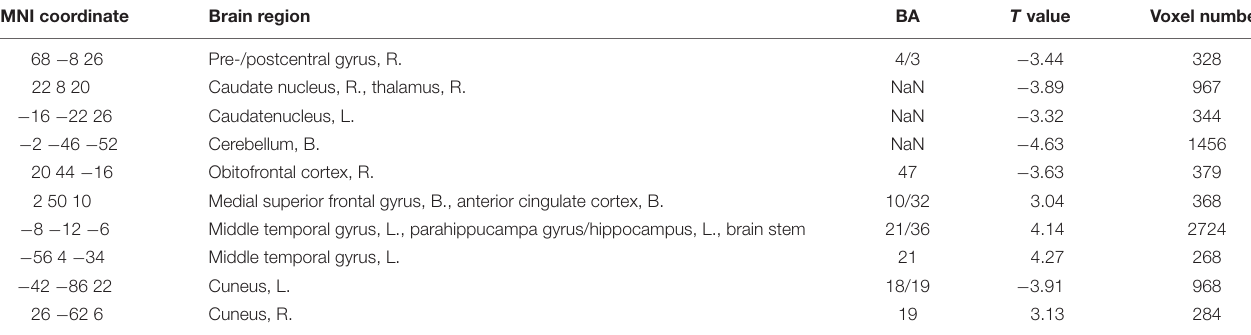
TABLE 2 | Regions showing significantly different connectivity with left GPi in TS patients as compared to controls. MNI coordinate Brain region BA T value Voxel number 68 − 8 26 Pre-/postcentral gyrus, R. 4/3